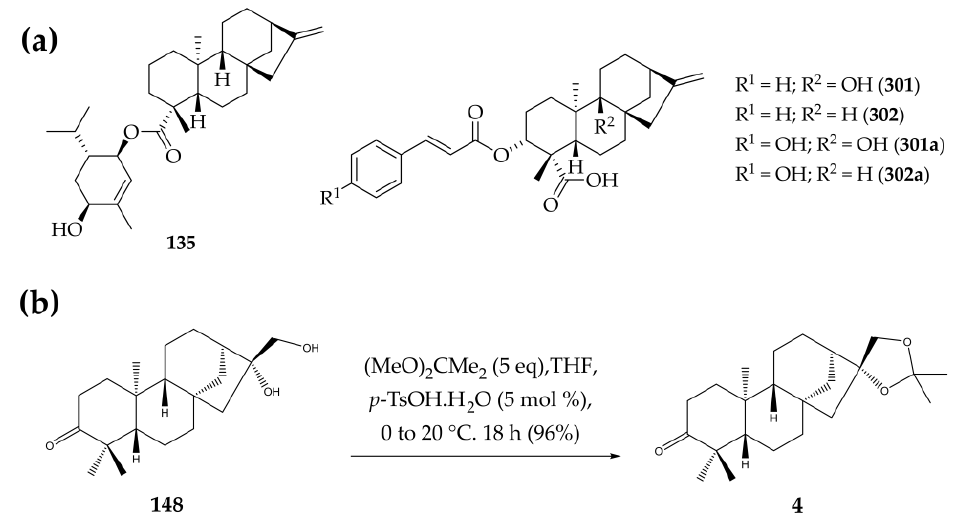
Figure 1. ( a ) Structures of selected kaurane-type diterpenes ( 135, 301, 302 ) and their derivatives ( 301a and 302a ). ( b ) Synthesis of compound 4 from structure 148.